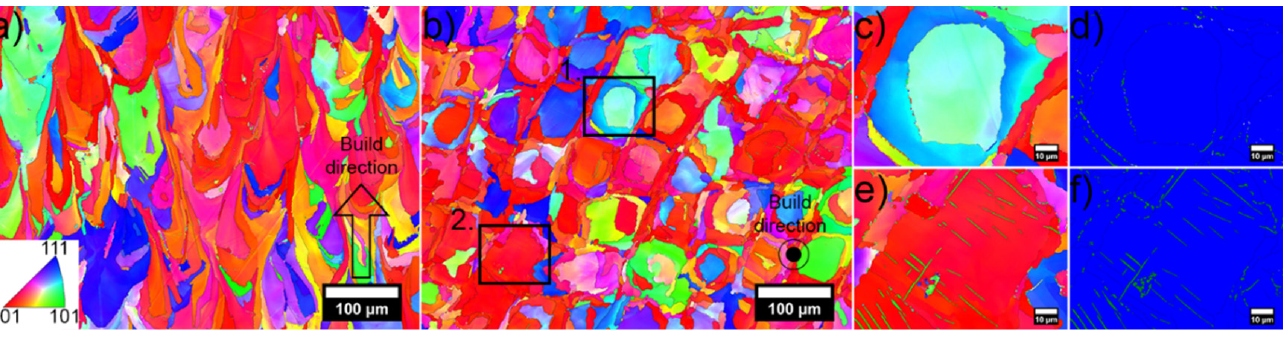
Figure 5. EBSD analysis of the as-built SS446 ferritic stainless-steel showing ( a ) EBSD orientation map along the build direction, ( b ) EBSD orientation map perpendicular to the build direction. The build direction is marked with an arrow in the images. ( c , d ) Show EBSD orientation map and phase map (ferrite in blue and austenite in green) of region 1 in ( b ). ( e , f ) show EBSD orientation map and phase map (ferrite in blue and austenite in green) of region 2 in ( b ).